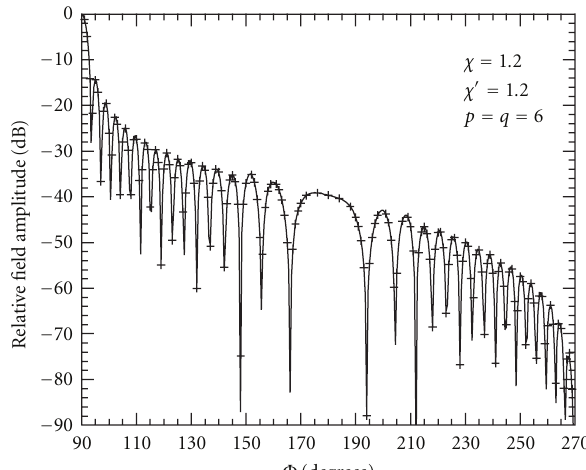
Figure 16: H-plane pattern. Solid line: exact. Crosses: reconstructed from NF